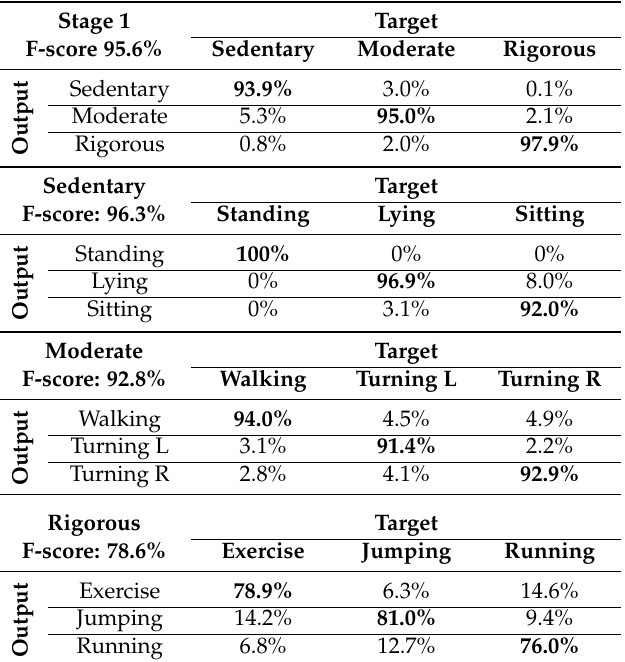
Table 7. Confusion matrices of the on-board classification